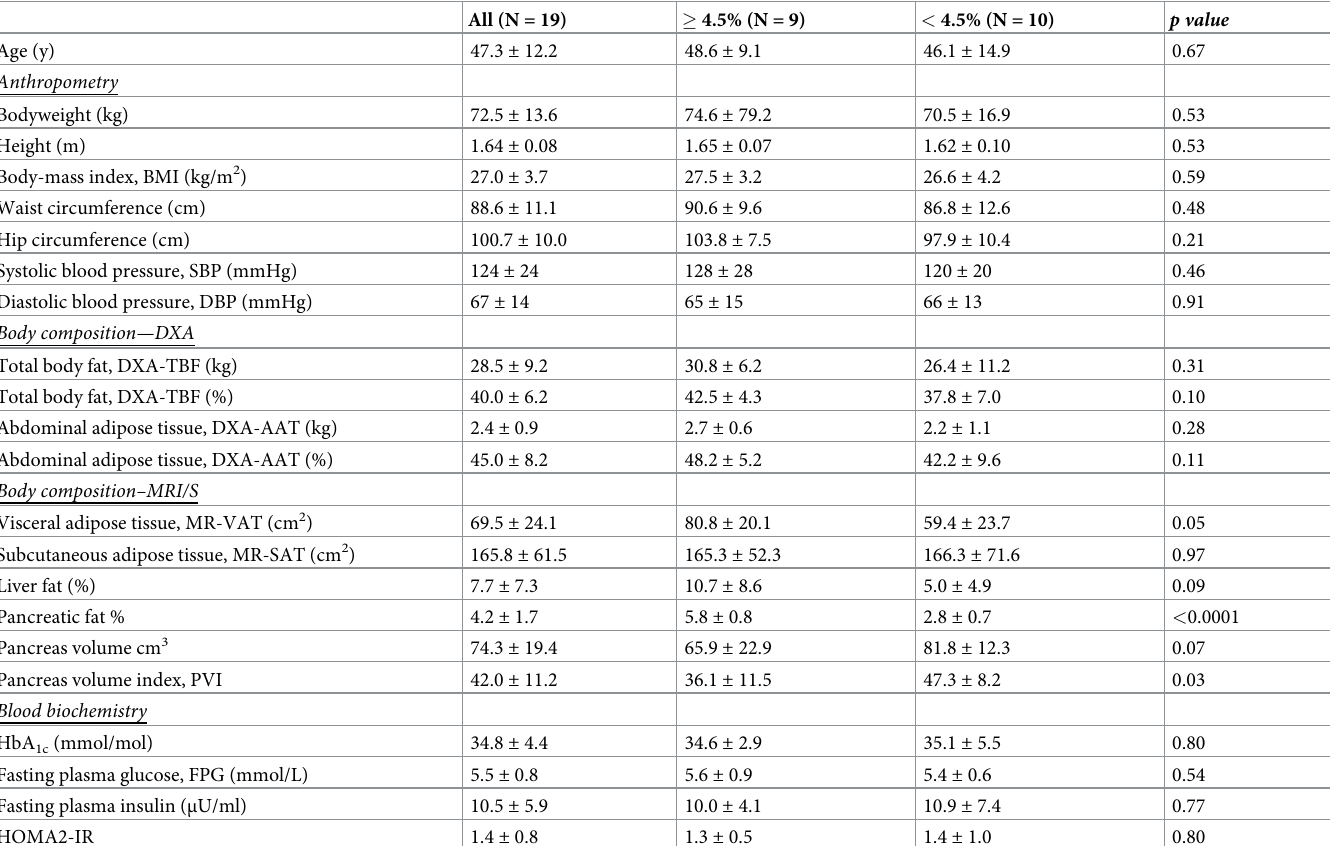
Table 2. Summary characteristics of baseline anthropometry and body composition in women identified with MRI-determined %pancreatic fat above and below